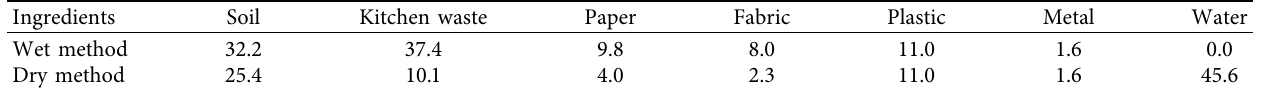
Table 4: Mass ratios of sample components